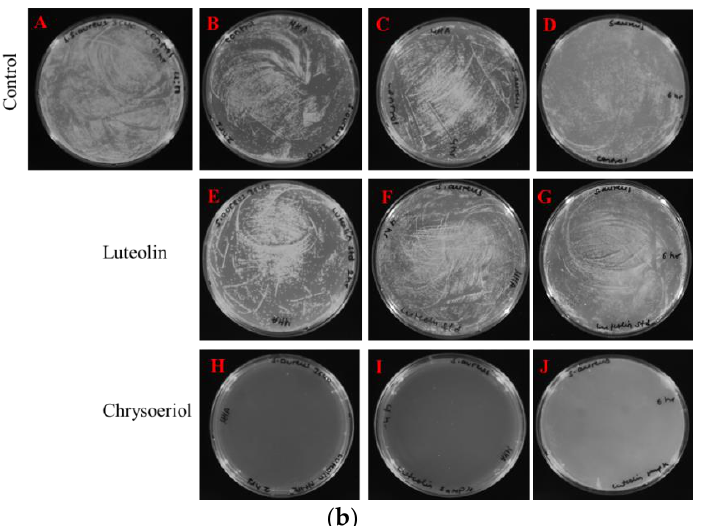
Figure 5. Colony-forming unit (CFU) count of chrysoeriol- and luteolin-treated microbes. ( a ) Proteus hauseri . Control ( A ) 0 h, ( B ) 2 h, ( C ) 4 h, and ( D ) 6 h. Luteolin-treated ( E ) 2 h, ( F ) 4 h, and ( G ) 6 h. Chrysoeriol-treated ( H ) 2 h, ( I ) 4 h, and ( J ) 6 h. ( b ) Staphylococcus aureus 3640 (MRSA). Control ( A ) 0 h, ( B ) 2 h, ( C ) 4 h, and ( D ) 6 h. Luteolin-treated ( E ) 2 h, ( F ) 4 h, and ( G ) 6 h. Chrysoeriol-treated ( H ) 2 h, ( I ) 4 h, and ( J ) 6 h.